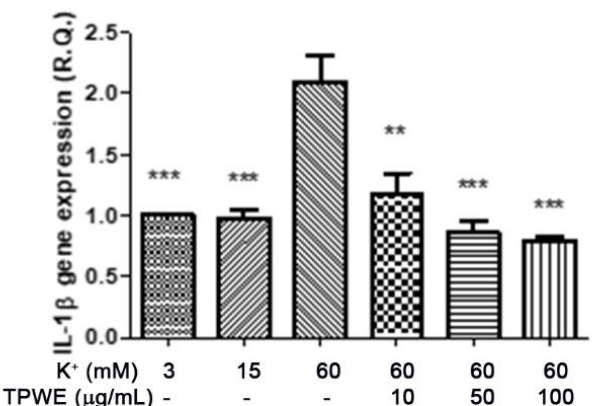
Figure 4. The inhibitory effect induced by the Tanacetum parthenium water extract (TPWE: 10–100 µg/mL) on interleukin-1β (IL-1β) gene expression (R.Q. = relative quanti- fication) in isolated cortexes challenged with K + 60 mM. ANOVA, p < 0.0001; ** p < 0.01, *** p < 0.001 vs. the K + 60 mM group.